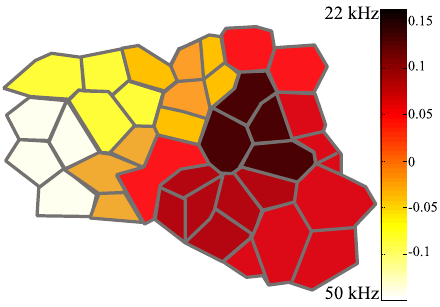
Figure 7. Example of an A1 map illustrating the sensitivity index ( SI) of the recorded sites.